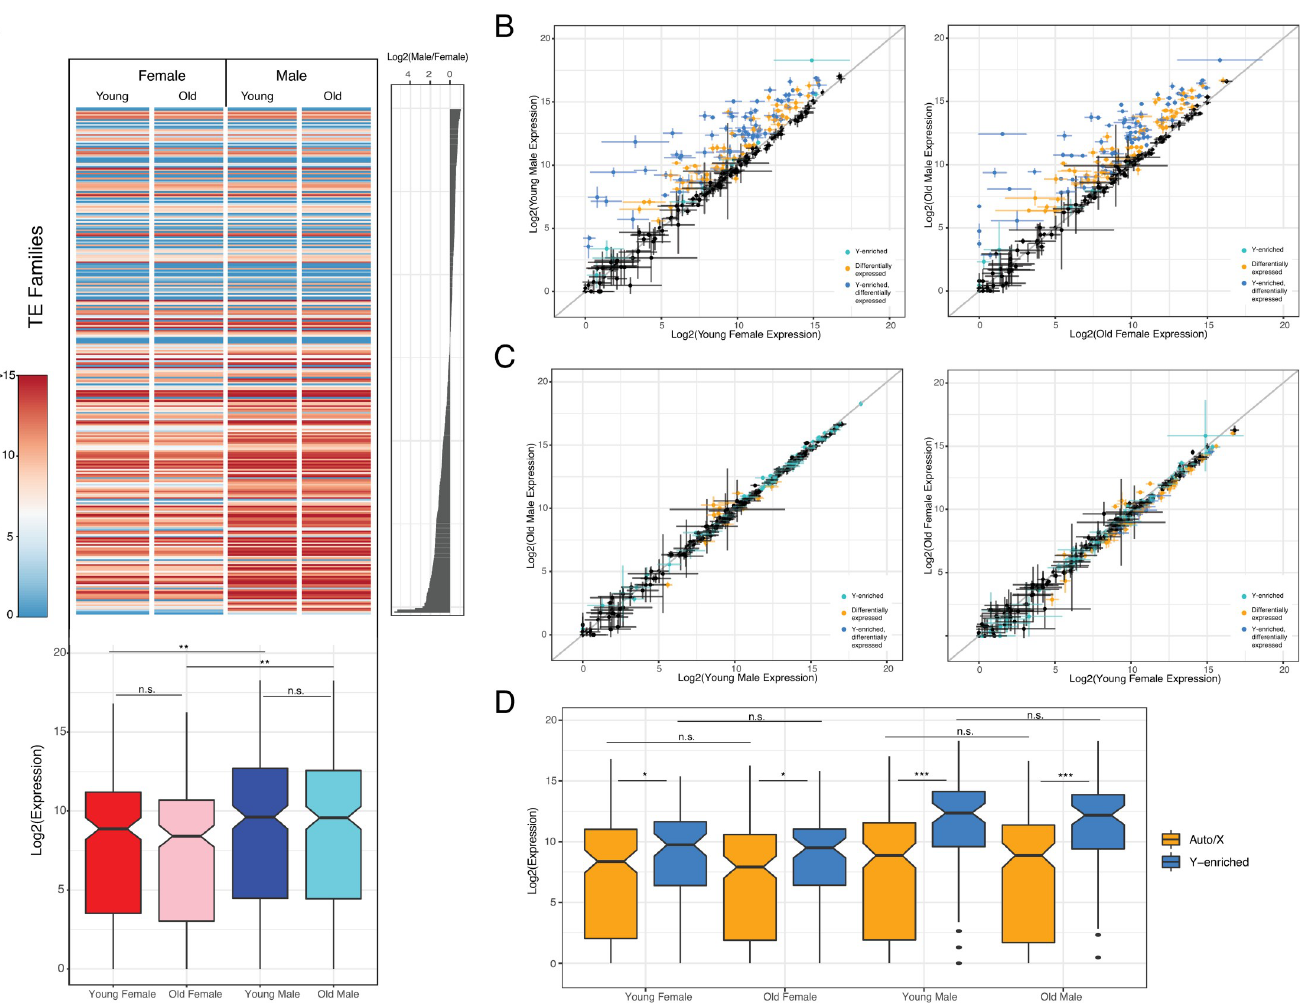
Fig 6. TEs are upregulated in male D . miranda . Shown is differential TE expression within and between sexes. A. Overall log2 expression by sex and age with rows sorted by log2 female/male TE coverage (right histogram). Boxplots below with significance values calculated using the Wilcoxon test ( � p < 0.05, �� p < 0.01, ��� p < 1e- 5). Data represents averaged expression across samples. B. Log2 expression differences of TEs between young (left) and old (right) males versus females. Data indicates mean value of 3 biological replicates and bars denote standard error. Color-code indicates significant comparisons (50% significant higher or lower expression; Wald test, p < 0.05) and Y-enriched repeats (based on genomic coverage): cyan: Y-enriched, p < 0.05; yellow: unbiased, p < 0.05; blue: Y-enriched, n.s.; black: unbiased; n.s. Grey line indicates 1:1 expression levels. C. Same as B but comparison between young vs. old males (left) and females (right). D. Log2 TE expression by sex and age grouped by TEs enriched on the neo-Y (blue) and TEs not enriched on the neo-Y (yellow). Significance values calculated using the Wilcoxon test ( � p < 0.05, �� p < 0.01, ��� p <